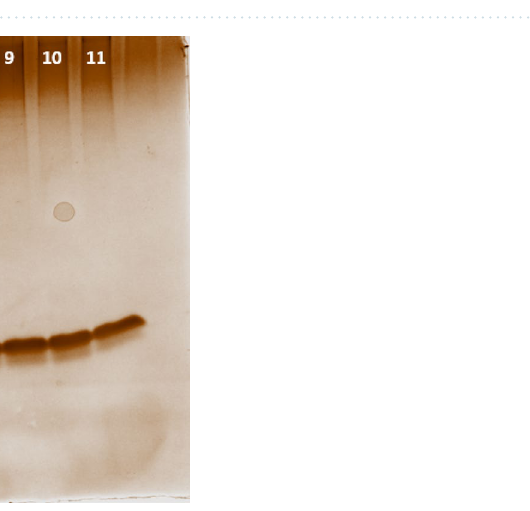
Figure 3. Analytical characterization of Samples 1–6. Relative abundance of Lys residues obtained by peptide mapping of free amino acids in RNase A conjugated with different scaffolds: glyoxyl-agarose (sample 1), CDI-agarose (sample 2), GPTS-agarose (sample 3), glutaraldehyde-agarose (sample 4), APTS-glutaraldehyde- agarose (sample 5) and CNBr-agarose (sample 6). Colors indicate the percentage abundance of each Lys residue normalized respect to the most abundant peptide in the corresponding analysis. The following legend was used: red 0–20%; orange 20–40%; yellow 40–60%; green 60–100%. Consequently, red = Lys bound to the carrier; green = Lys exposed on the surface, not involved in the binding. Created with PyMOL Molecular Graphics System (version 1.1 eval, http://www.pymol .org).